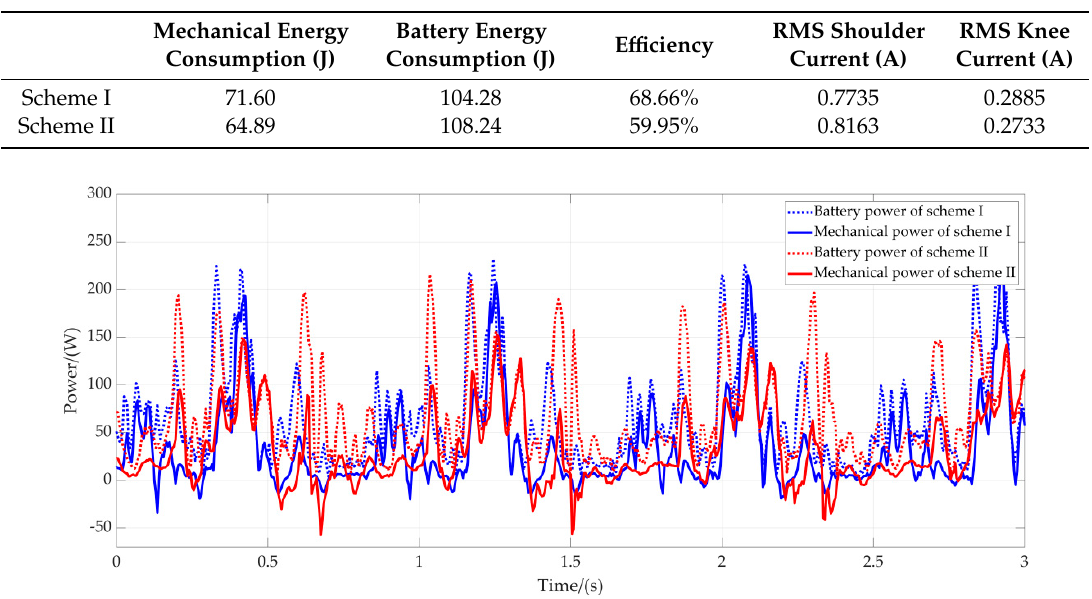
Figure 20. Power consumption of two schemes in V desired =2m/s.